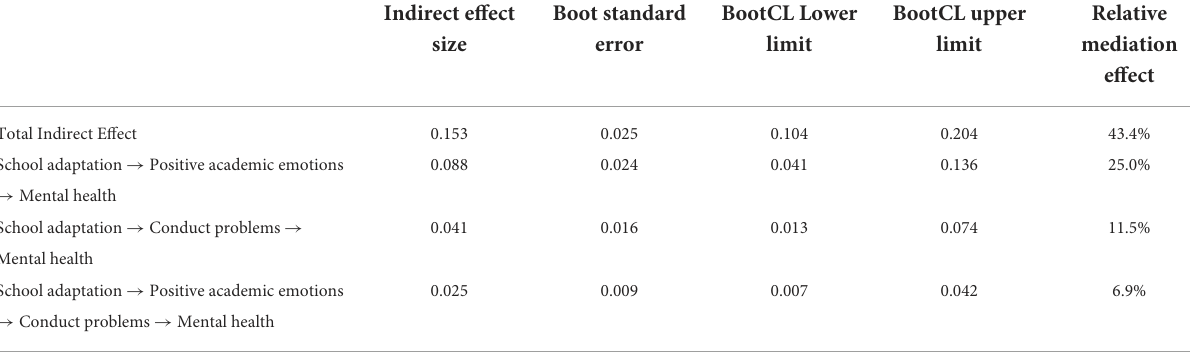
TABLE 4 Test of chain mediation effect of school adaptation for immigrant